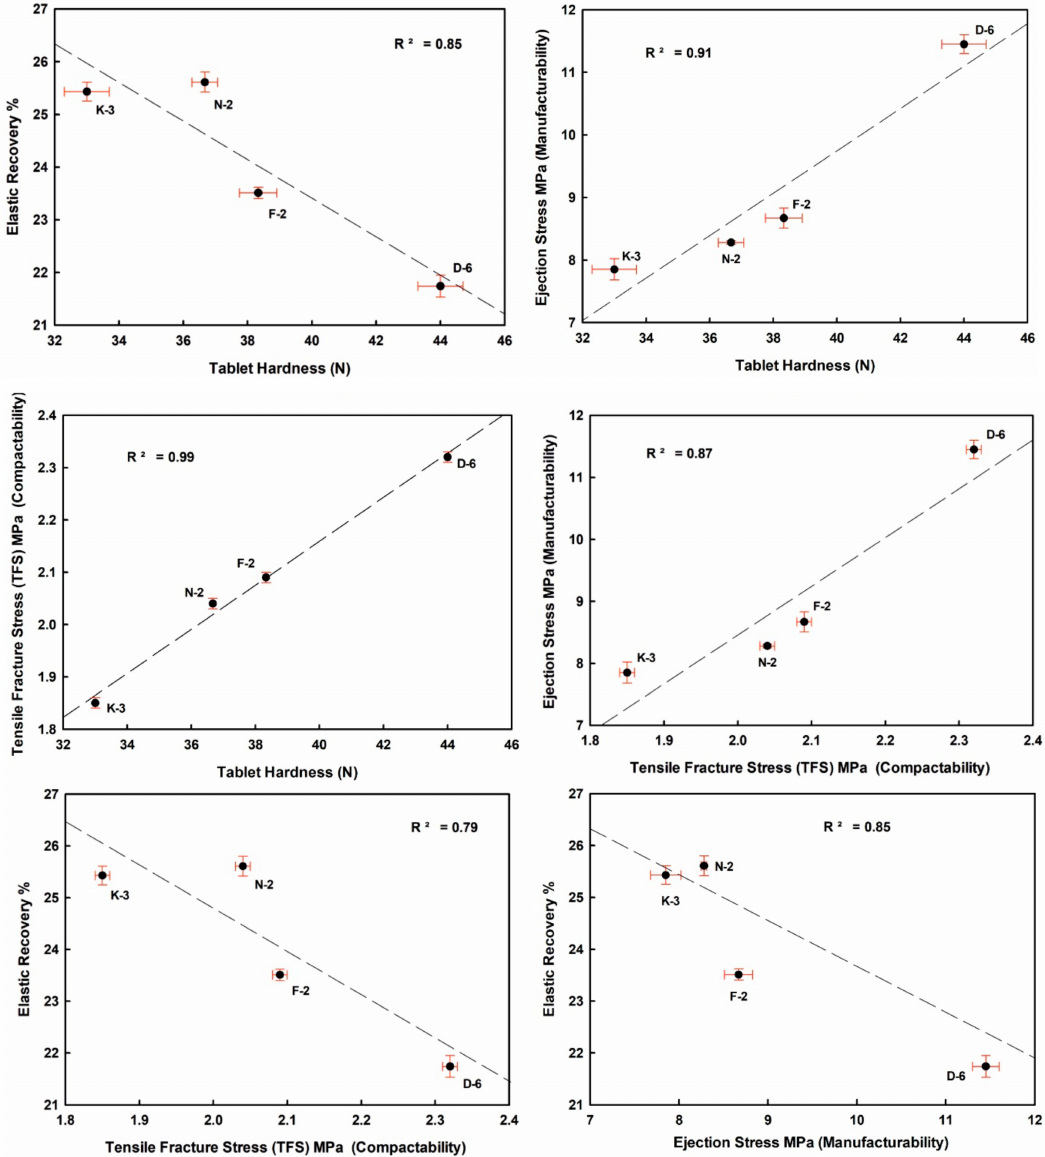
Figure 10. Mutual interrelationships of the tableting parameters (ER, ES, TFS) and against tablet hardness (H) of the studied compressed kaolin powder